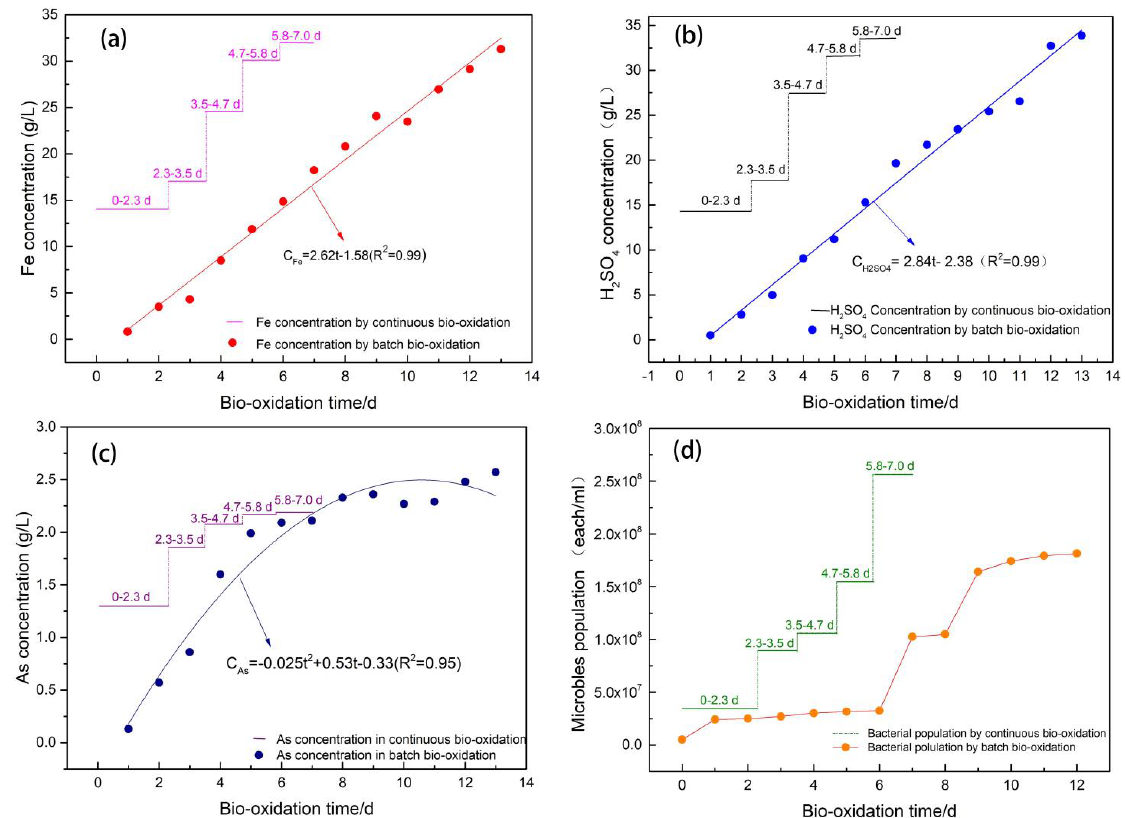
Figure 5. Ion concentrations and microbe populations in batch and continuous bio-oxidation, ( a ) Fe concentration, ( b ) H 2 SO 4 concentration, ( c ) As concentration, ( d ) microbe populations.